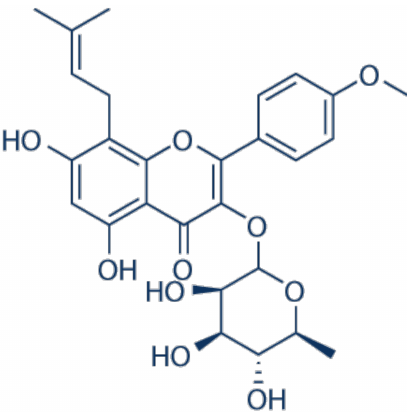
Figure 22. The chemical structure of icariside II.